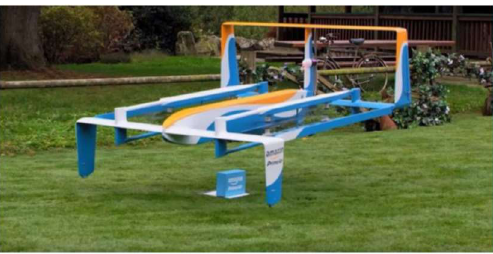
Figure 3. Amazon Prime Air drone delivery prototype [13]